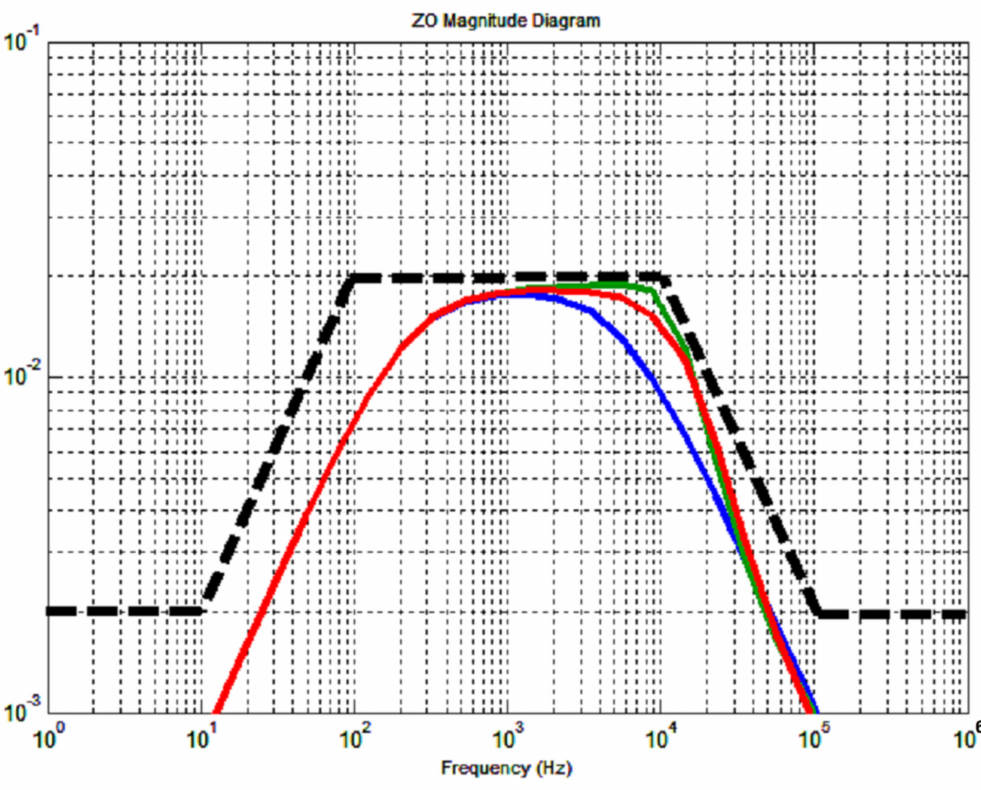
Figure 9. Output impedance simulation: blue, no delay; green, Csa delay; red, Csa delay + lead–lag network.